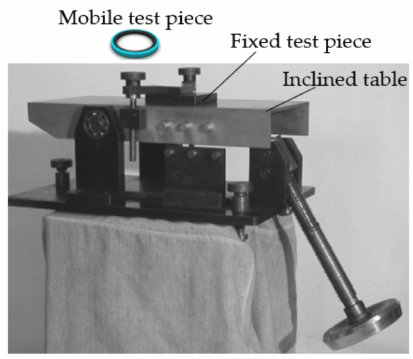
Figure 3. High precision